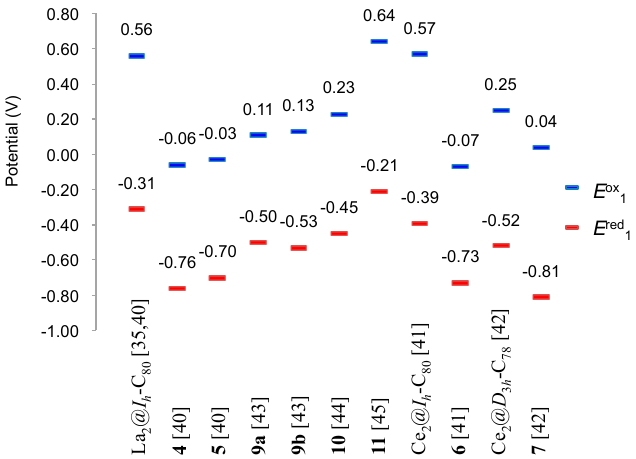
Figure 3. Redox potentials (in V vs. Fc/Fc + ) of pristine and derivatized dimetallofullerenes.